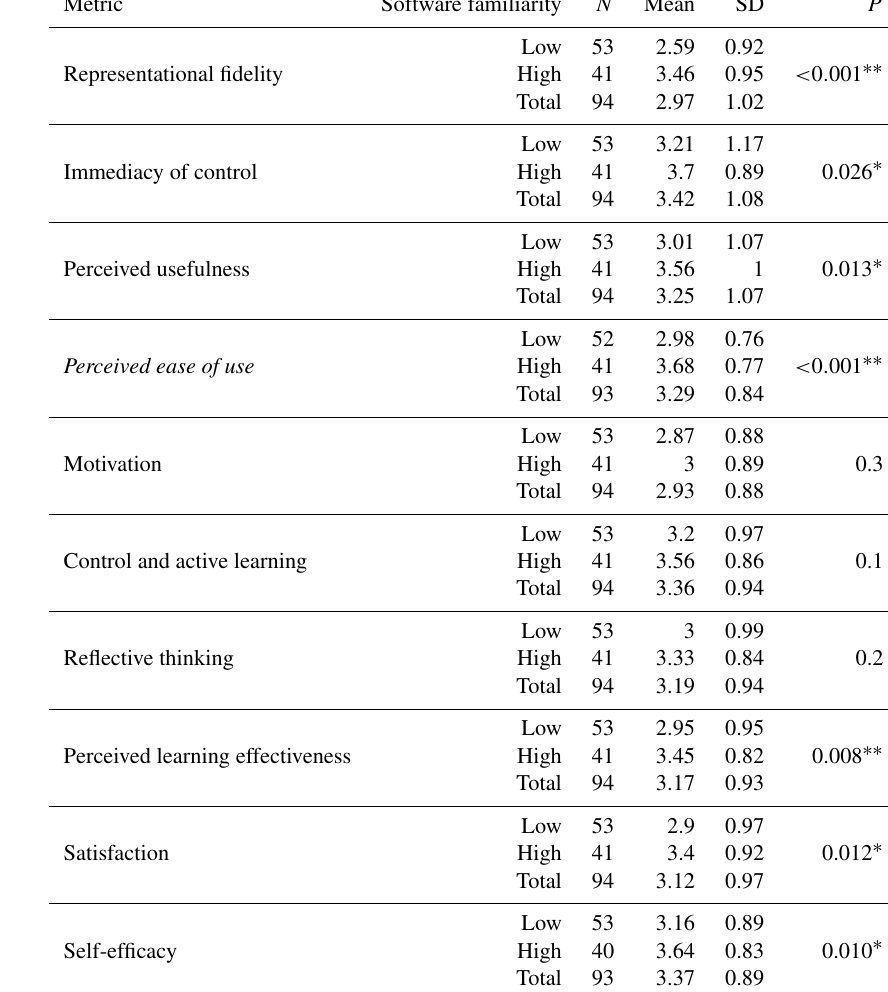
Table 3. Results of an independent samples t test comparing students grouped by software familiarity.